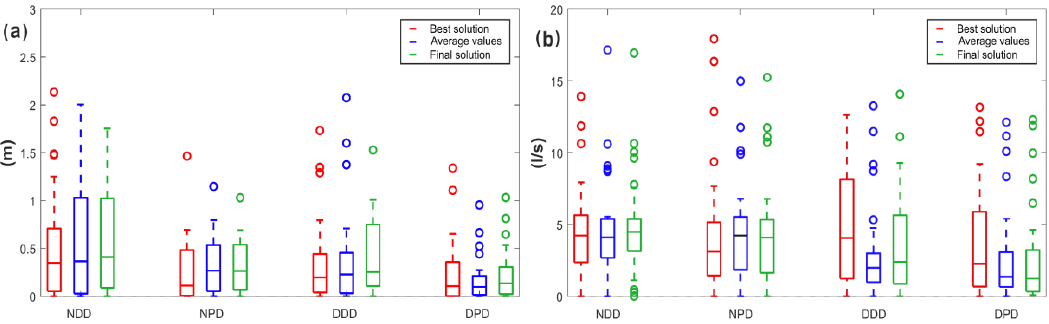
Figure 6. Comparison of the solutions. ( a ) Pressure absolute errors; ( b ) flow rate absolute errors. Error distribution of the best solution among the 100 runs (left box); average values (middle box); final solution (right box).